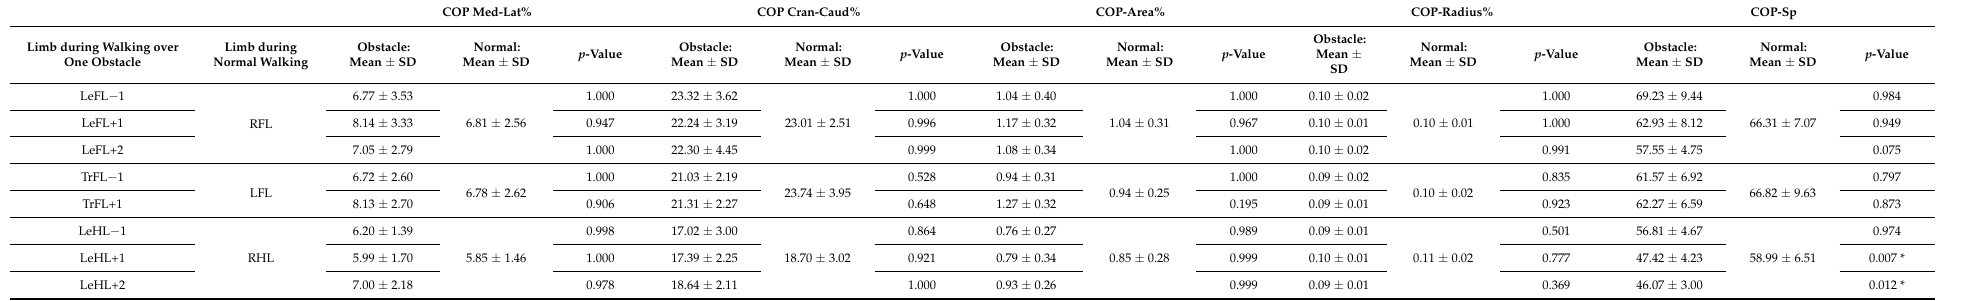
Table A2. Mean values, standard deviations, and significant differences in COP values between walking over one obstacle and normal walking. COPMed-Lat%